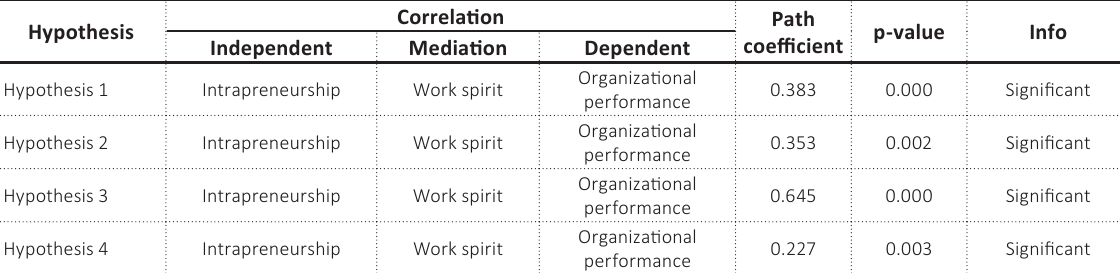
Table 5. Path coefficient